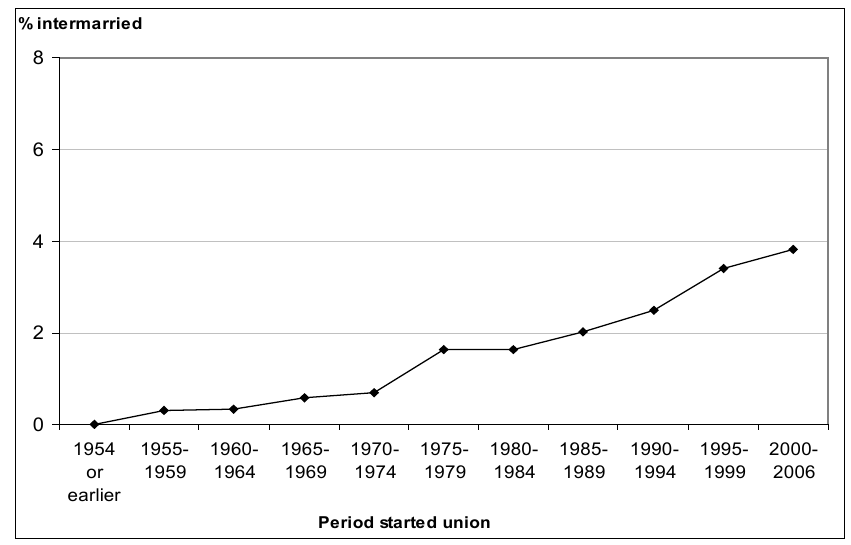
Figure 1: Percentage of interethnic unions between White British and ethnic minority members by period a union was